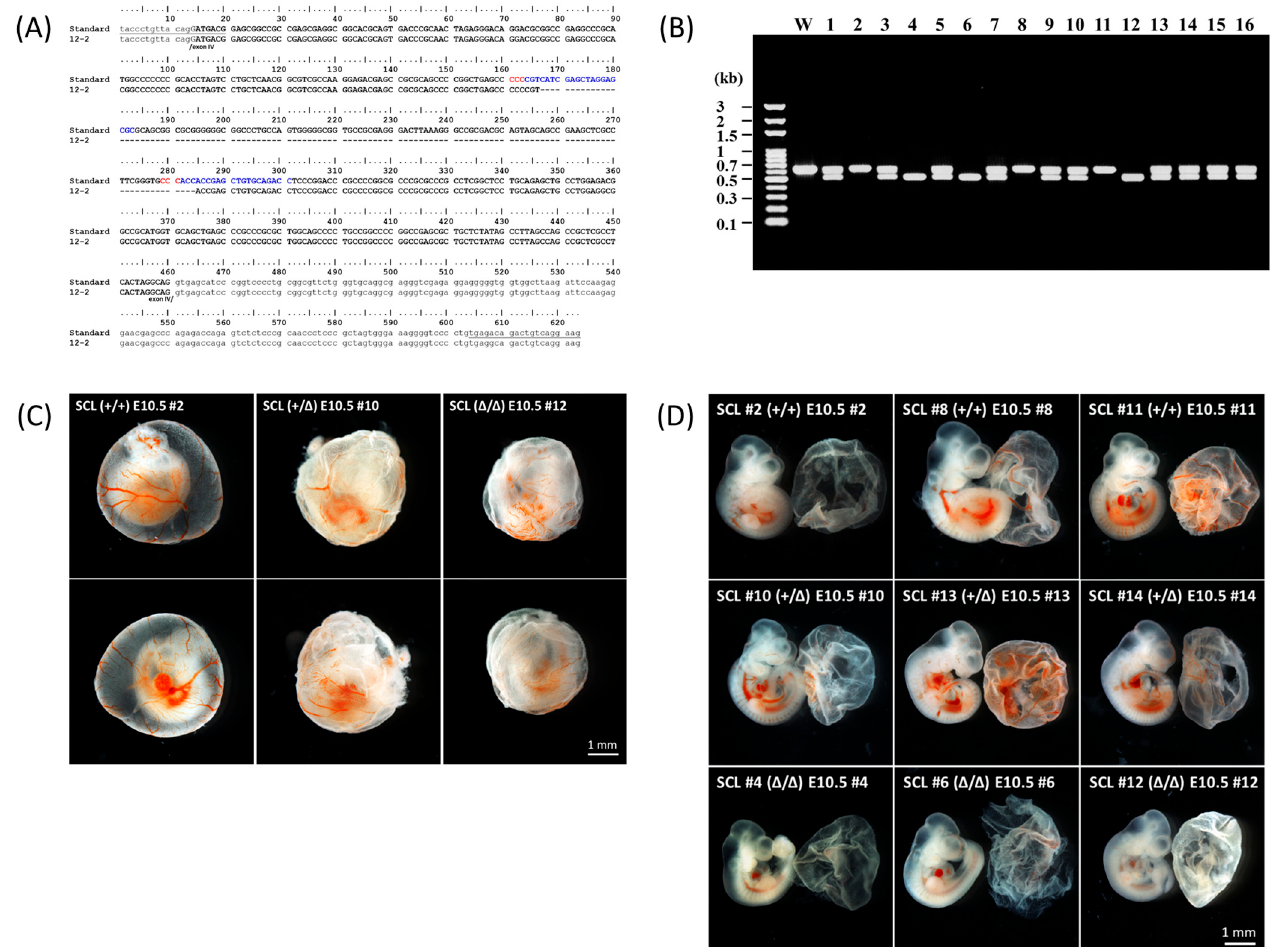
Figure 1. Mutation of mouse SCL gene with a deletion in exon IV ( A ) The sequences of the PCR amplification region are presented, in which the protospacers and PAM are shown in blue and red letters, respectively, and the 118 bp deletion found in the F 0 founder for breeding is located by a dashed line. Primers for PCR are underlined. ( B ) A litter of embryos taken as an example. In this